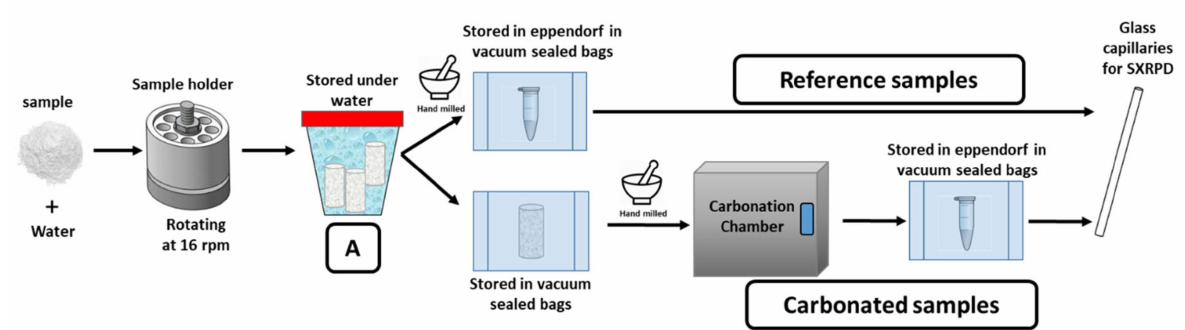
Figure 1. Sketch of the experimental procedure employed to prepare the samples.